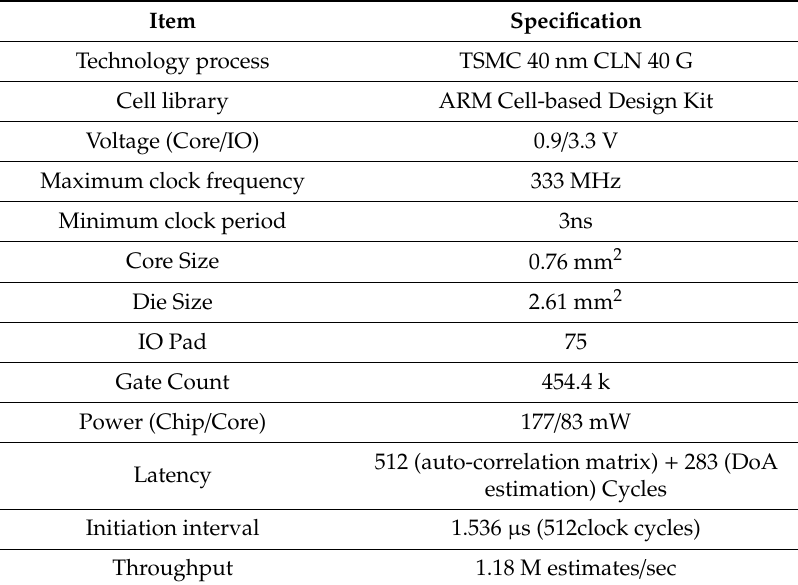
Figure 19. Layout of the proposed DoA estimation accelerator chip design. Table 5. Accelerator chip design summary.